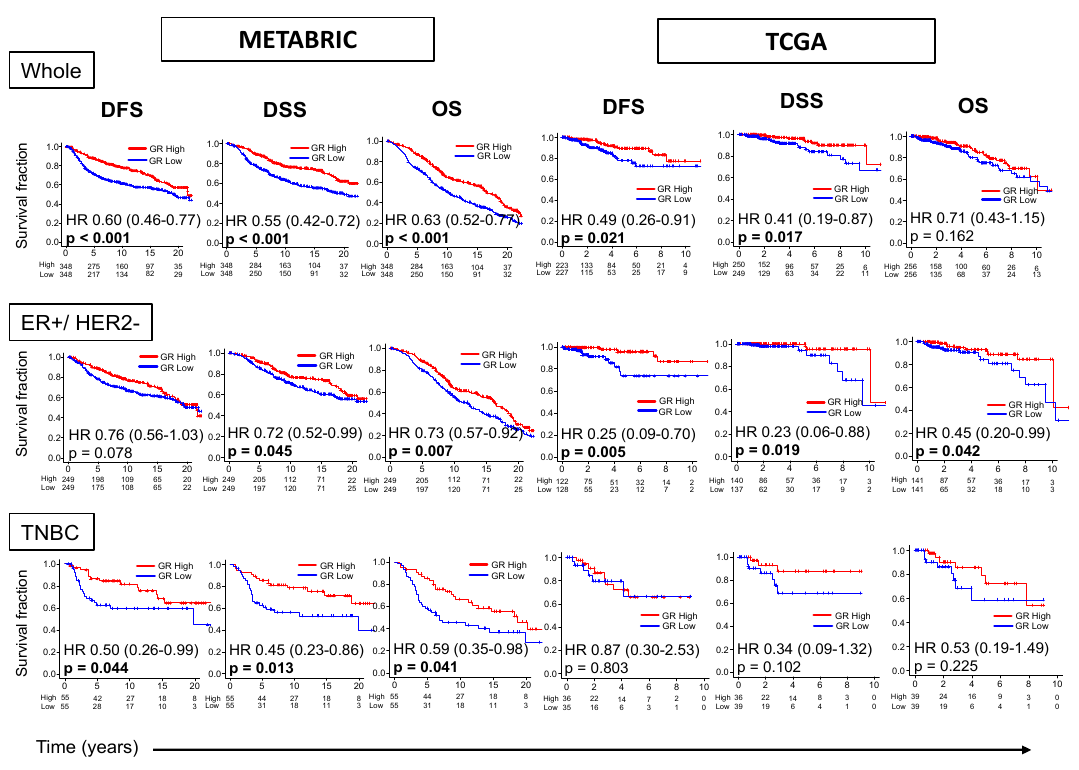
Figure 1. GR expression and survival outcomes in breast cancer. Kaplan–Meier survival plots comparing patients with high and low GR expression along with logrank test p values and hazard ratios (HR) with confidence intervals are shown for disease-free (DFS), disease-specific (DSS) and overall survival (OS) for the entire cohort (Whole), or its sub-groups of estrogen receptor(ER)-positive/human epidermal growth factor receptor (HER2)-negative and triple negative (TNBC) breast cancer. The cut-off of top and bottom quartile of NR3C1 expression was considered as GR high and GR low in the whole cohort and the respective subtypes. Log-rank test was used to compare the survival between GR high and GR low breast cancer.